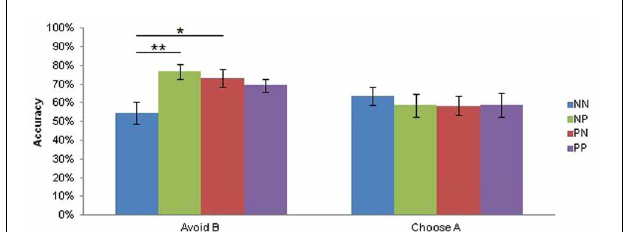
FIGURE 4 | Test Condition by Group interaction on test accuracy. There was a significant Test Condition by Group interaction ( p < 0 . 05). Subjects did not differ in approach (Choose A) accuracy during the test, but subjects who listened to neutral music during both training and testing (NN) avoided B less accurately than those who listened to neutral music during training and pleasurable music during testing (NP; adjusted p < 0 . 005) and those who listened to pleasurable music during training and neutral music during testing (NP; adjusted p < 0 . 05). Bars depict the mean accuracy for each Group in Choose A and Avoid B conditions, plus or minus the standard error of the mean. PP, subjects who listened to pleasurable music during both training and testing. ∗ p < 0 . 05; ∗∗ p < 0 .